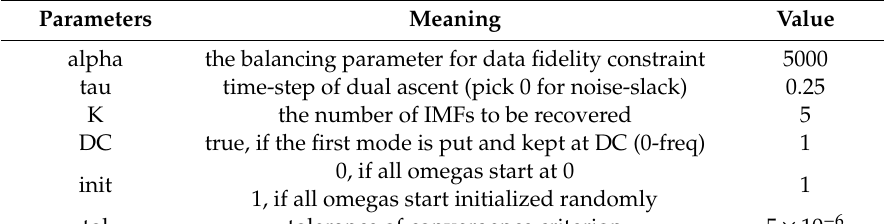
Table 3. 2D-VMD algorithm parameter in the paper.